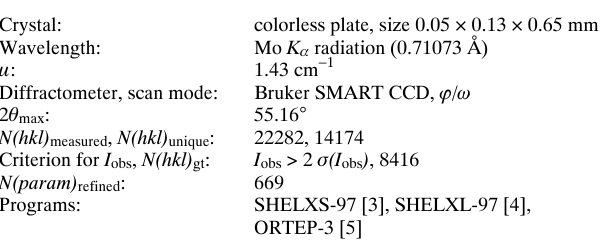
Table 1. D a t a collection a nd h a ndling.